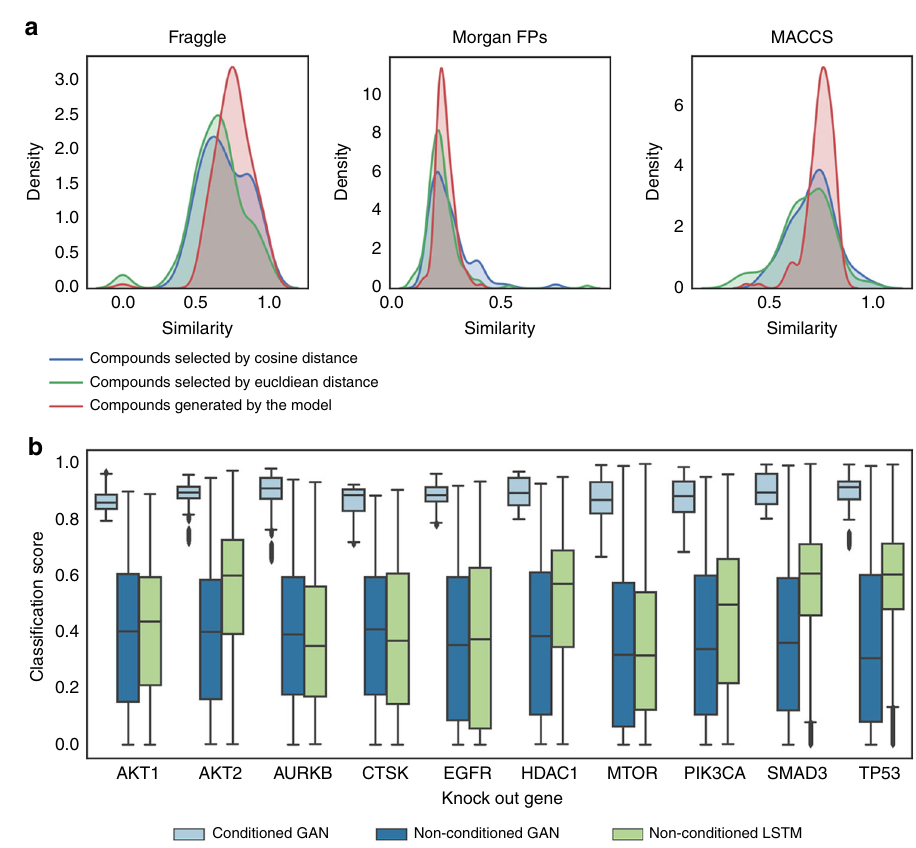
Fig. 5 Benchmarking of conditioned generative adversarial network (GAN) with similarity-based search and non-conditioned models. a Distribution of structural similarity scores between generated molecules or compounds selected from the training set using similarity search and their closest known active molecule. Conditioned GAN generated more active-like compounds than those found by similarity search using the gene expression signature of a target knock-out. b Comparison of conditioned GAN (light blue) with a non-conditioned GAN (blue) and a non-conditioned LSTM (green) to generate compounds for a speci fi c target. The centerline of the boxplot represents the median; the bounds of the box represent the fi rst and third quartile and the whiskers the 1.5 interquartile rage